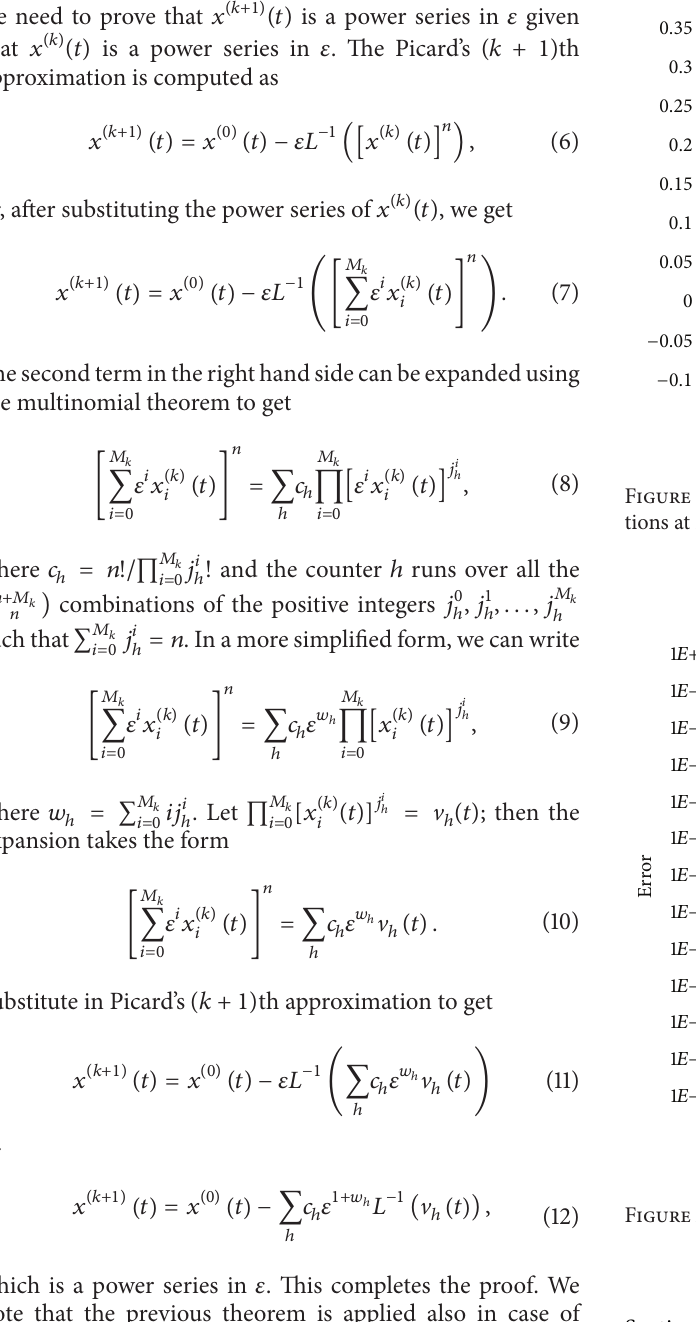
Section 4. The simulations up to third order and fourth correction are shown in Section